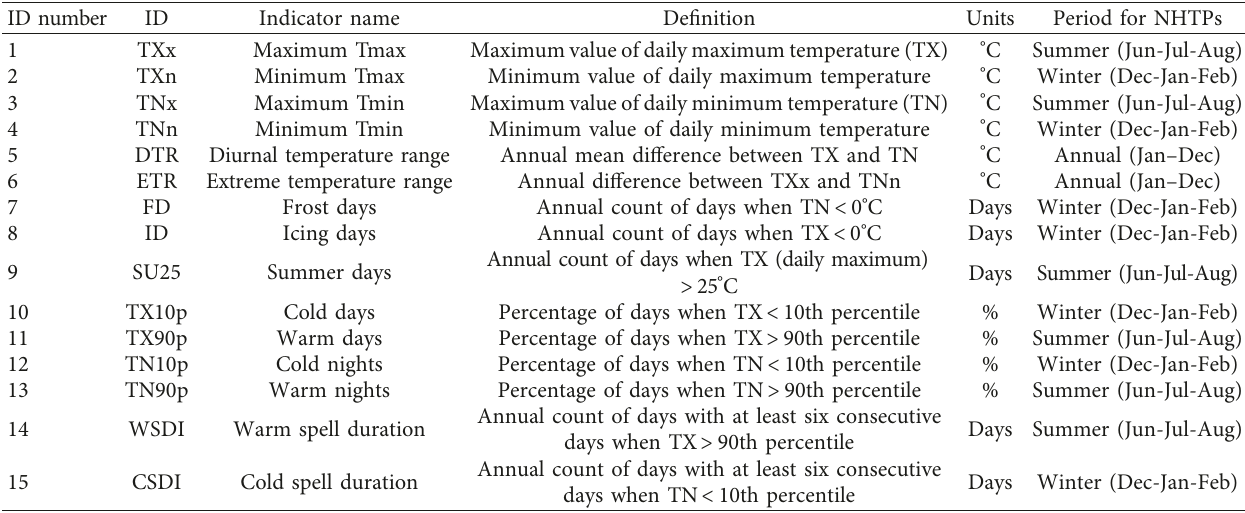
Table 1: Definitions of selected daily extreme temperature indices and their period of Northern Hemisphere teleconnection patterns (NHTPs) for this study.